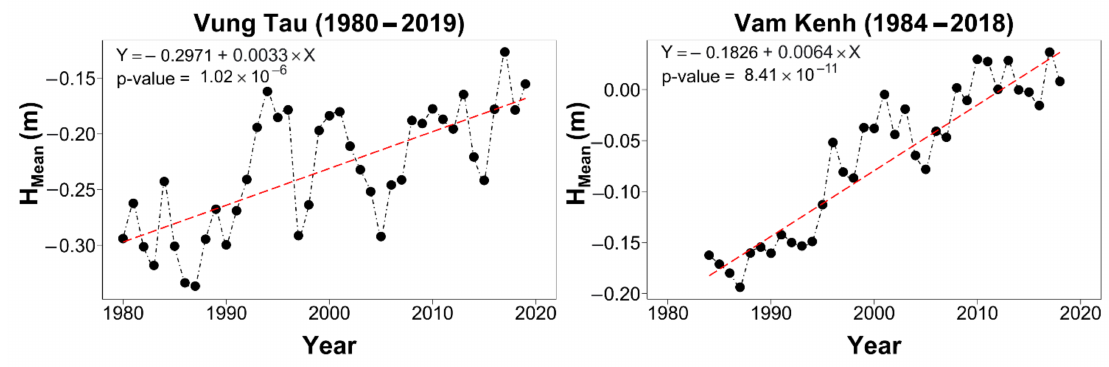
Figure 5. Annual medium water level trends H mean .